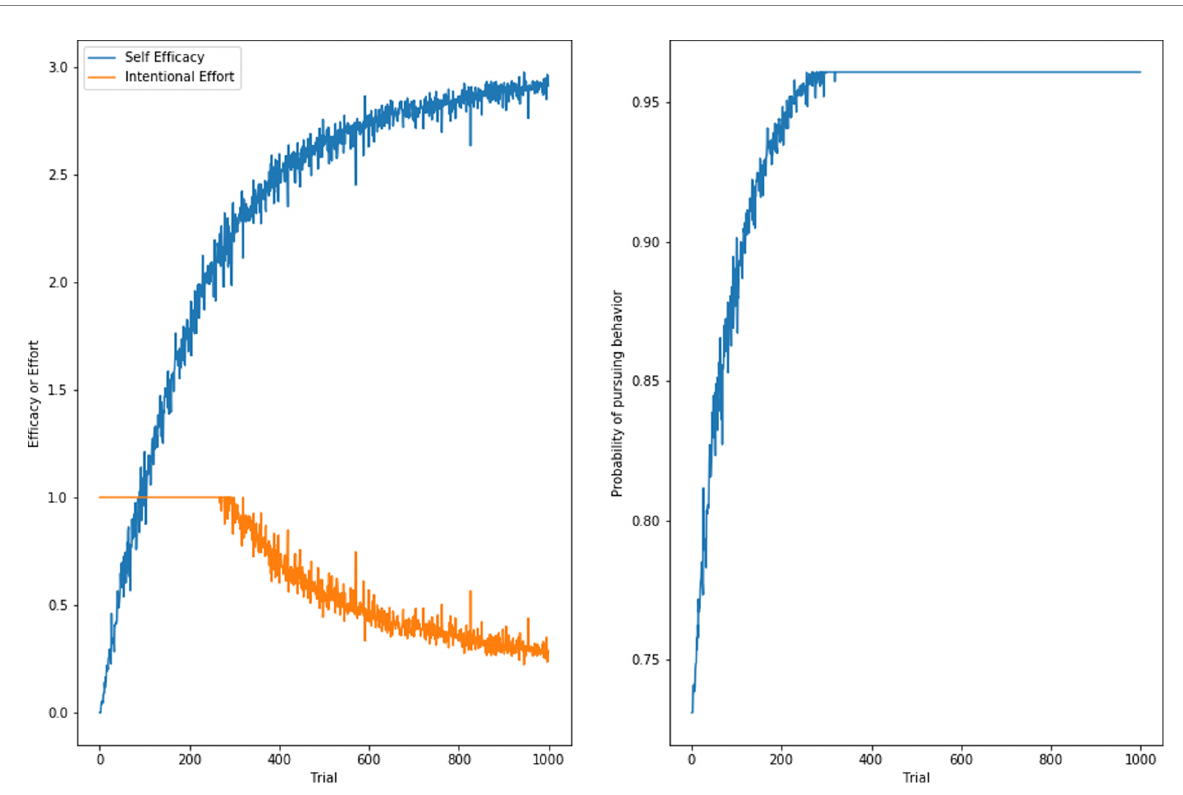
FIGURE 5 The dynamics of self-efficacy and intentional effort over time (left) and the impact on the probability of pursuing a behavior (right).